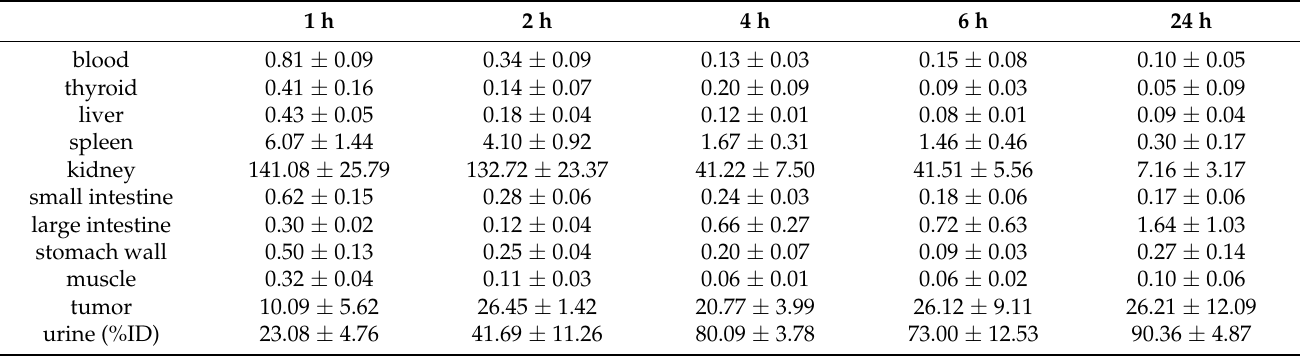
Table 8. Results of biodistribution of the [ 99m Tc]Tc-PSMA-T4 complex in BALB/c NUDE mice bearing LNCaP tumor (%ID/g, mean ± SD, n =